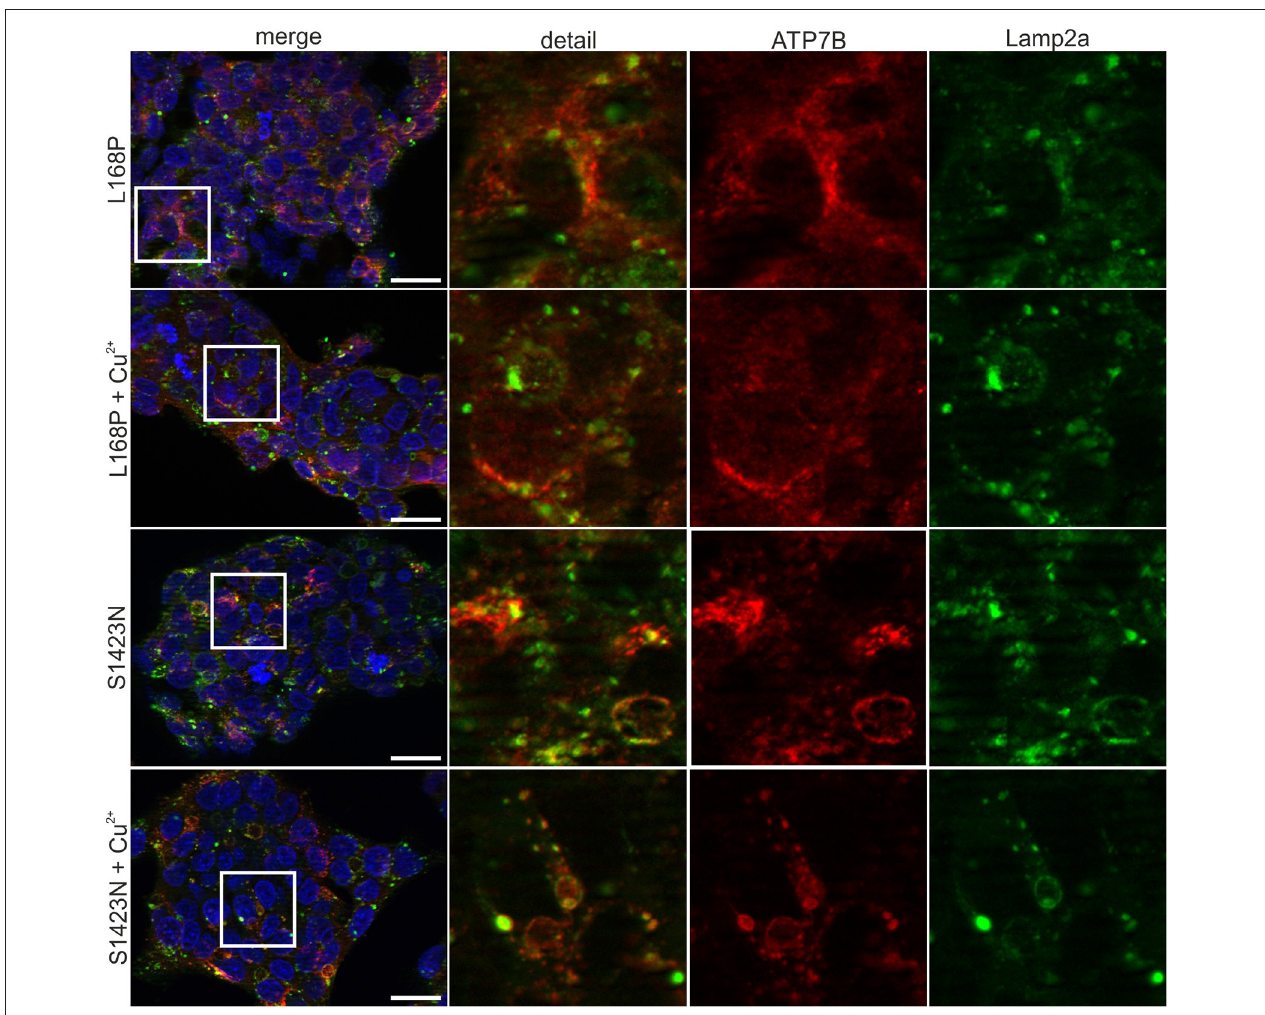
FIGURE 3 | Confocal microscopy before and after addition of copper. For mutant p.L168P, a dispersed cytoplasmically staining of ATP7B was observed at low and high copper. For mutant p.S1423N, a co-localization with late endosome-lysosome marker lamp2 was observed at low copper concentrations. Elevated copper did not show typical trafficking of this mutant. One representative experiment out of three is shown. Scale bar, 20 µ